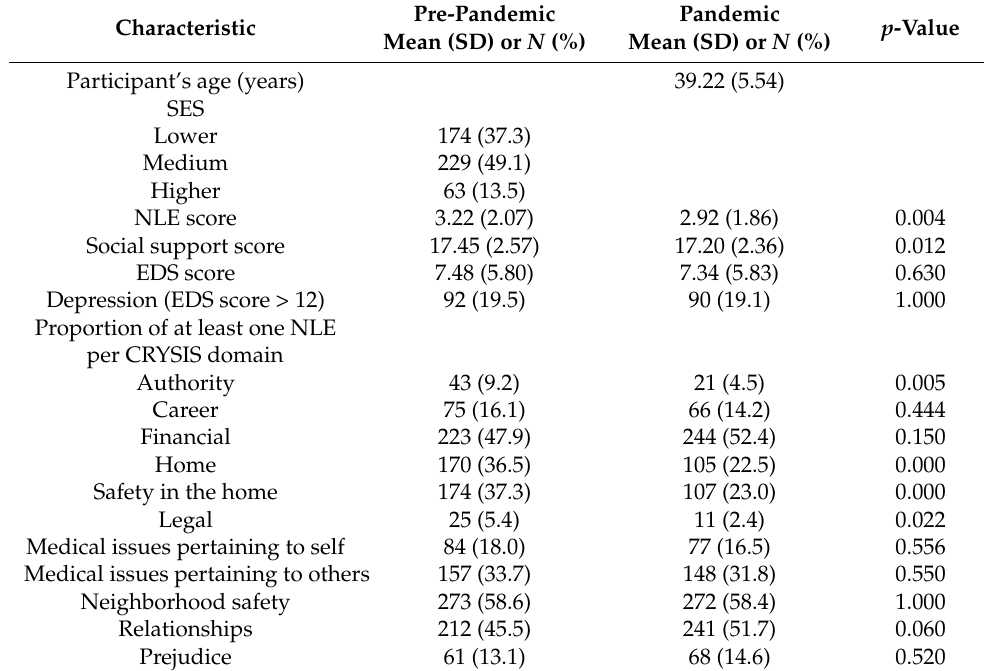
Table 1. Characteristics of women in the PROGRESS study pre-pandemic and during the pandemic.